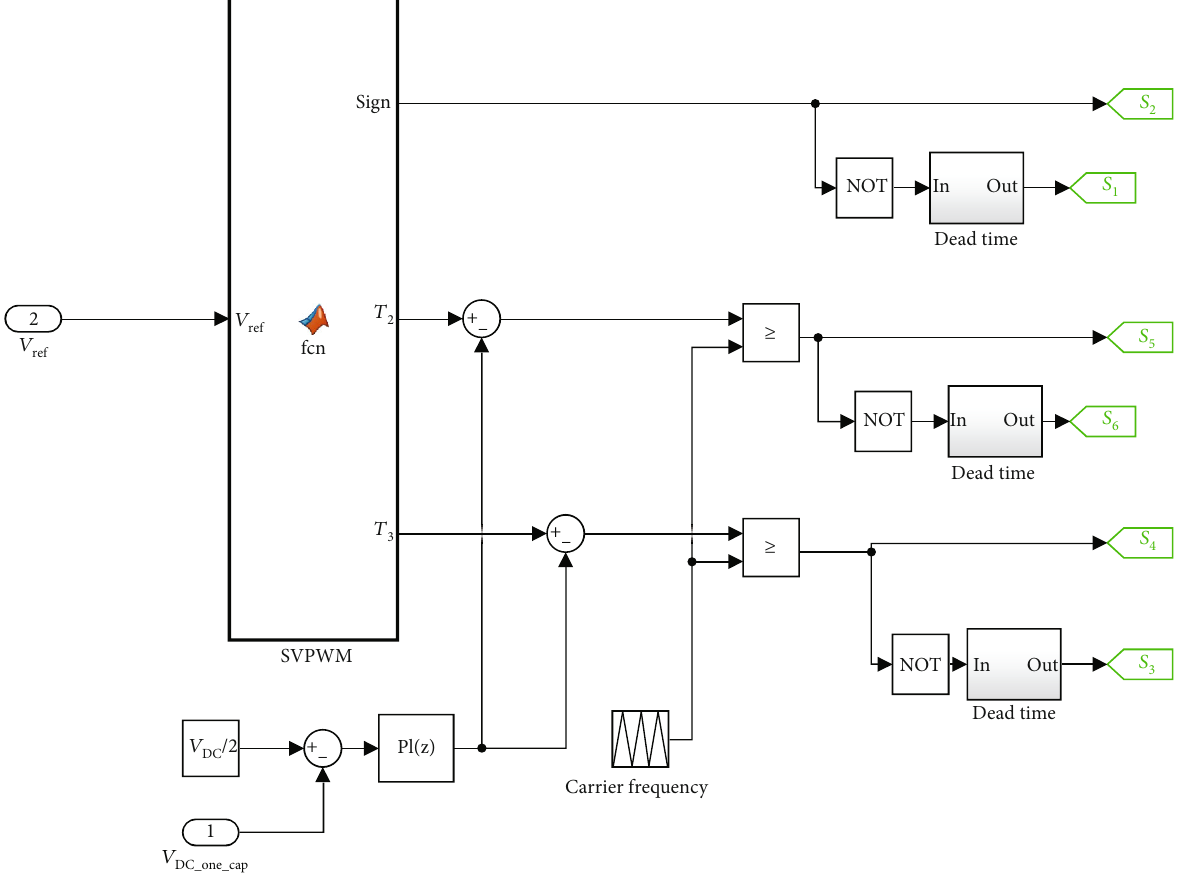
Figure 5: DC link capacitor voltage balancing control loop. Table 2: Open- and closed-loop simulation